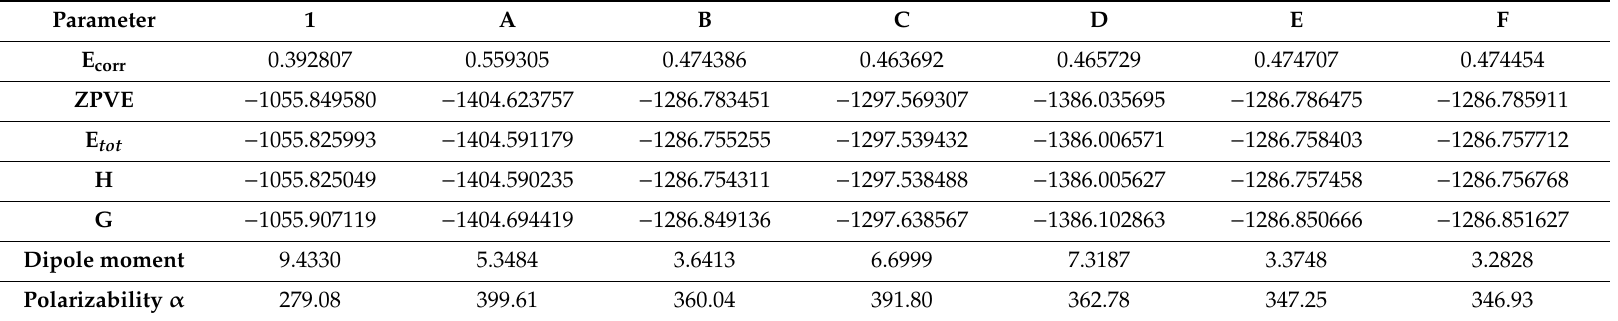
Table 3. Thermal parameters (Hartree / Particle), Dipole Moment (Debye), and polarizability of compounds 1 and A – F .